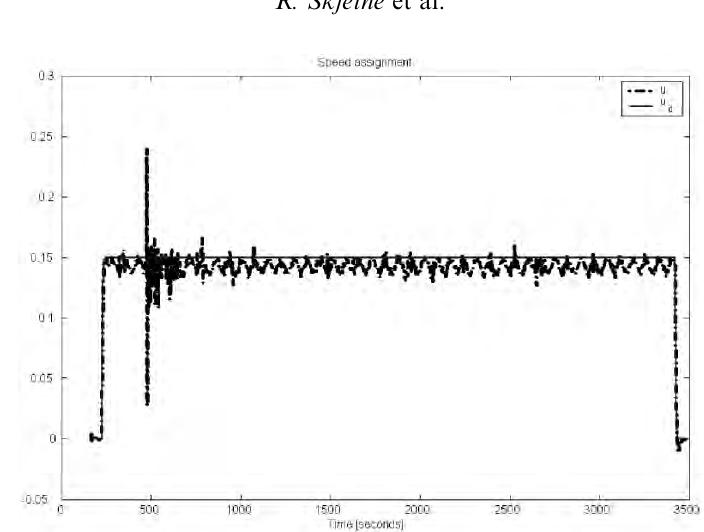
Figure 13. The desired and actual surge speed of CyberShip II for the full experiment. Notice the discrepancies around t B 500 s which resulted from position measurement outages.